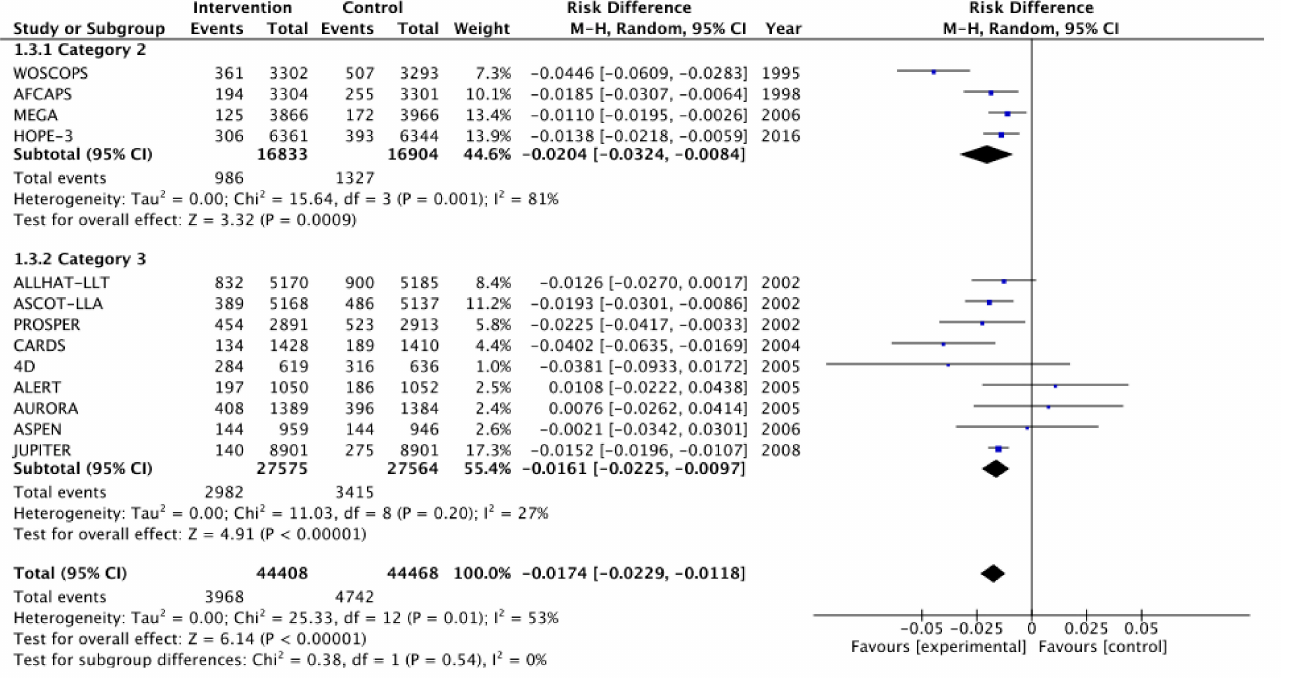
Figure 7. Risk difference across Category 2 and 3 studies for the tertiary outcome of all CVD events combined. Heterogeneity across studies was high, so random effects were used for the meta-analysis (Heterogeneity: Chi 2 = 25.33, p < 0.05, I 2 =